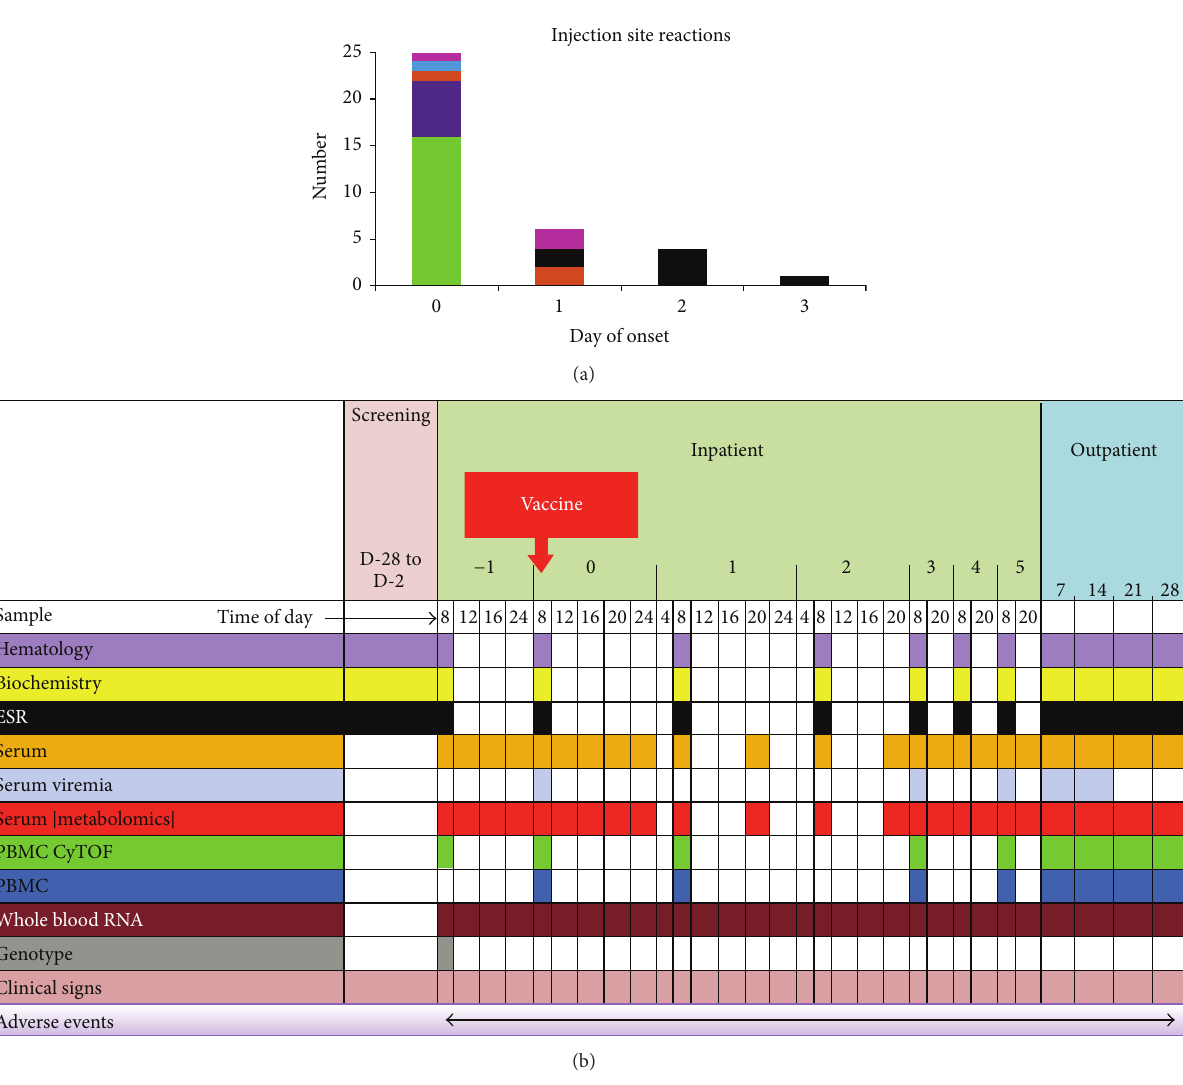
Figure 3: (a) Day of onset for injection site reaction for five different vaccines plus saline placebo (blue), (b) schedule of sampling for systems vaccinology parameters during intensive inpatient